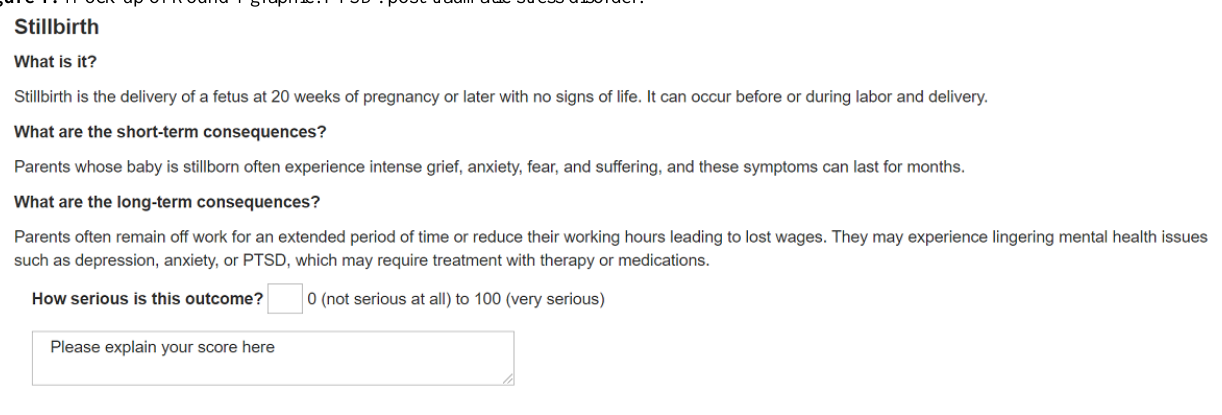
Figure 1. Mock-up of Round 1 graphic. PTSD: post-traumatic stress